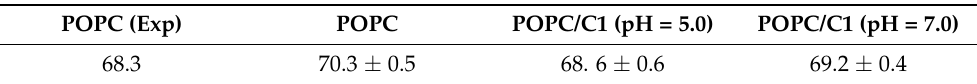
Table 3. Area per lipid of a POPC membrane in the absence and presence of the C1 probe at different pH values.